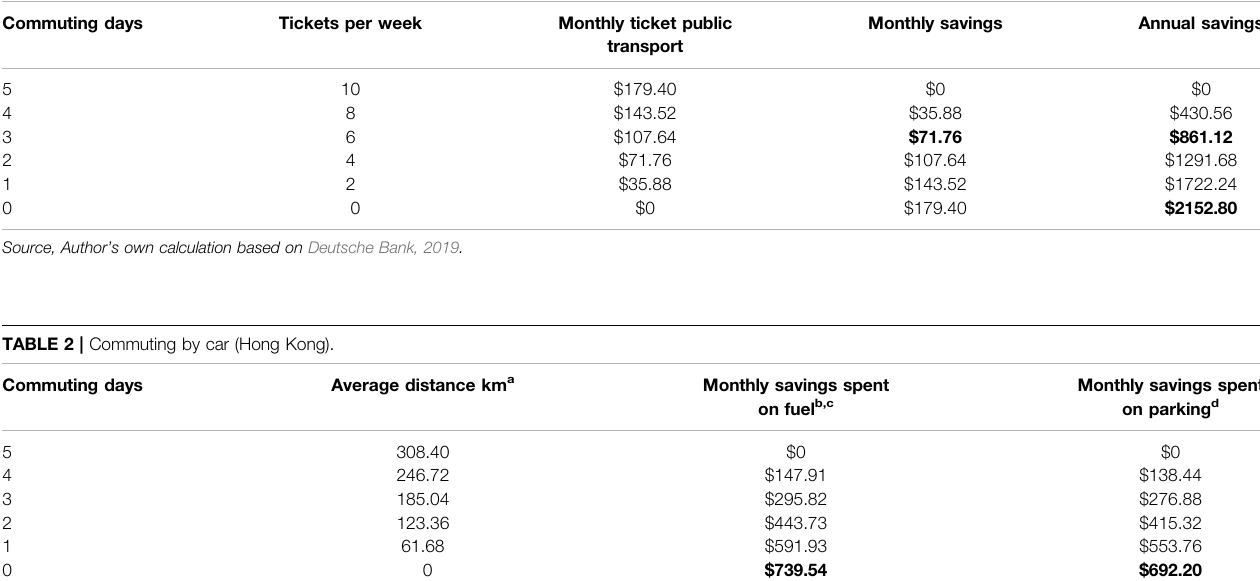
TABLE 1 | Commuting (London).